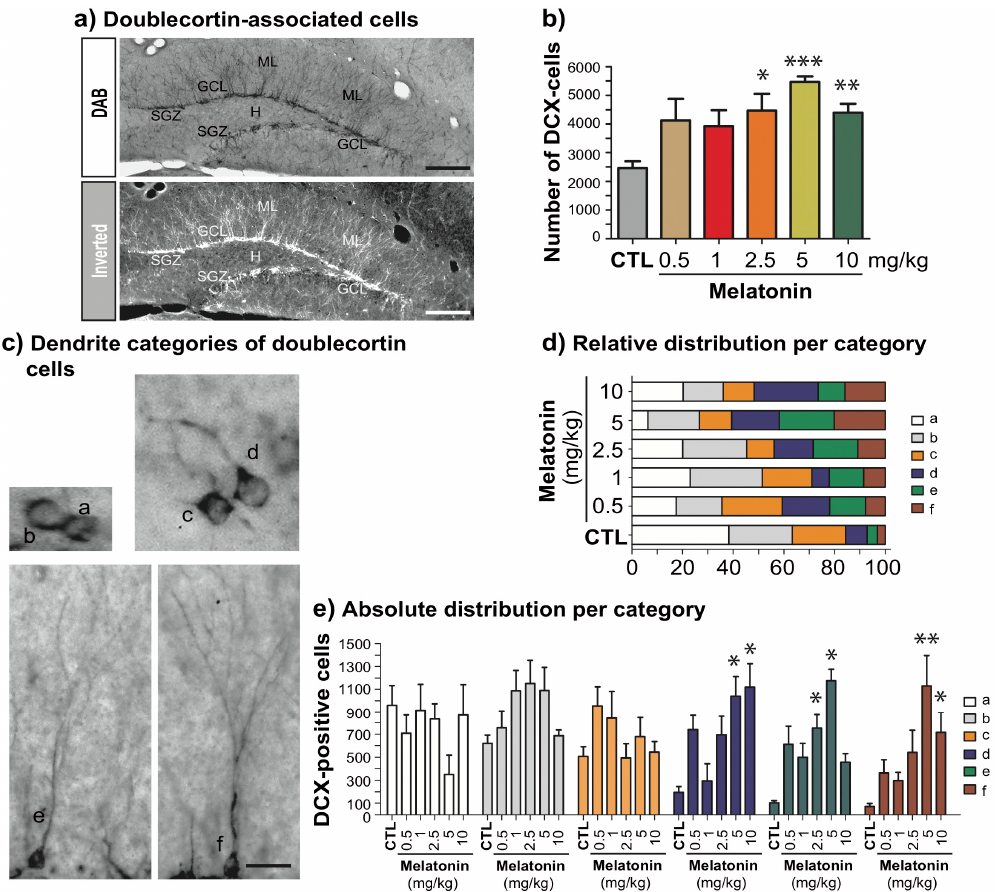
Figure 2. Doublecortin-associated cells located in the dentate gyrus of adult male Balb / C mice. ( a ) Mice were intraperitoneally injected either with 0.5, 1, 2.5, 5 and 10 mg / kg of melatonin or vehicle for 14 days. Coronal sections within the hippocampus are shown, and doublecortin (DCX)-associated cells were identified with an anti-doublecortin antibody. Representative pictures show the subgranular zone delimited by DCX-associated cells (SGZ). Some cells are integrated into the granular cell layer (GCL), and some of their dendrites reach the molecular layer (ML). Images also show the hilus (H). Scale bars represent 200 μ m. ( b ) Chronic melatonin (2.5, 5 and 10 mg/kg) administration induced a significant increase in DCX-associated cells in comparison with the vehicle. Error bars represent standard error of the mean (SEM). Asterisks indicate p = 0.045, 0.002, 0.039; respectively. Representative bright-field images corresponding to the different morphologies ( a – f ) are also shown in panel ( c ). Scale bar represents 20 μ m. ( d ) Relative distribution per category of DCX-labelled cells is shown and ( e ) absolute quantification based on a percentage per category and the total number of DCX-labelled cells confirmed a significant increase in more appearing mature neurons caused by higher doses of melatonin. Error bars represent SEM. Asterisks indicate p = 0.001 for category “d”, p = 0.028, <0.001 for category “e”; and p < 0.001, 0.031 for category “f”. n = 6 mice per group.